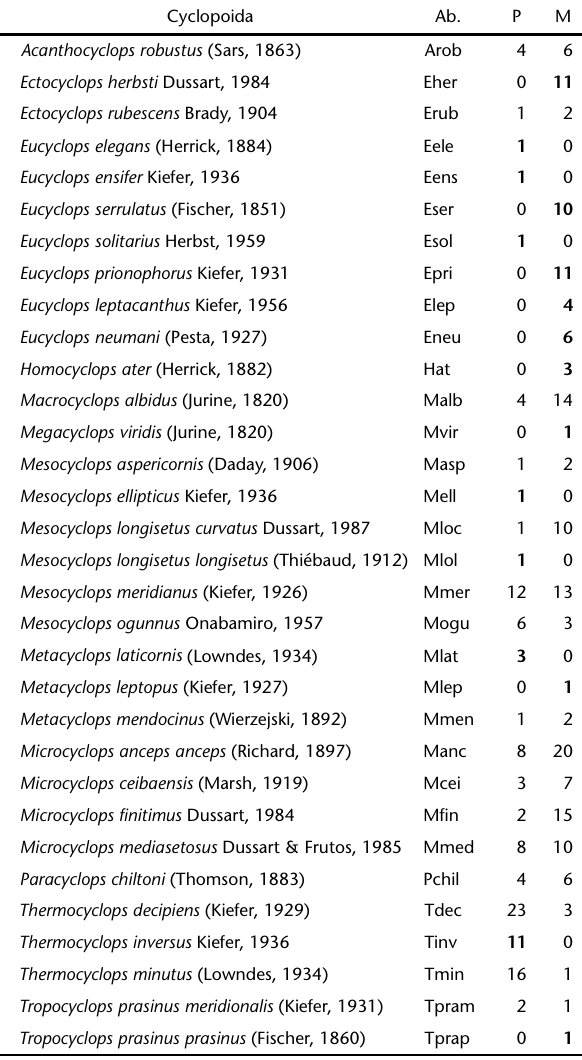
Table I. List of cyclopoid species with respective abbreviations (Ab) for NMDS, and number of occurrences in sampling sites at plankton (P) of limnetic zones (from a total of 24 sites) and within macrophytes stands (M) samples (from a total of 24 sites). In bold occurrences only in plankton or